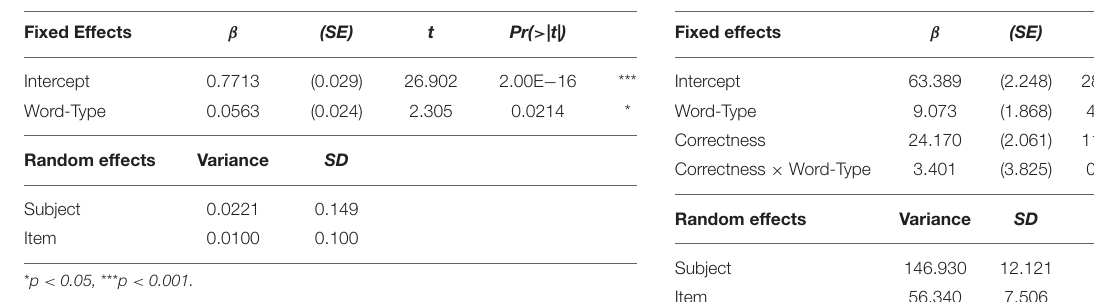
TABLE 3 | L2 meaning accuracy LMER output. TABLE 4 | L2 meaning sureness LMER